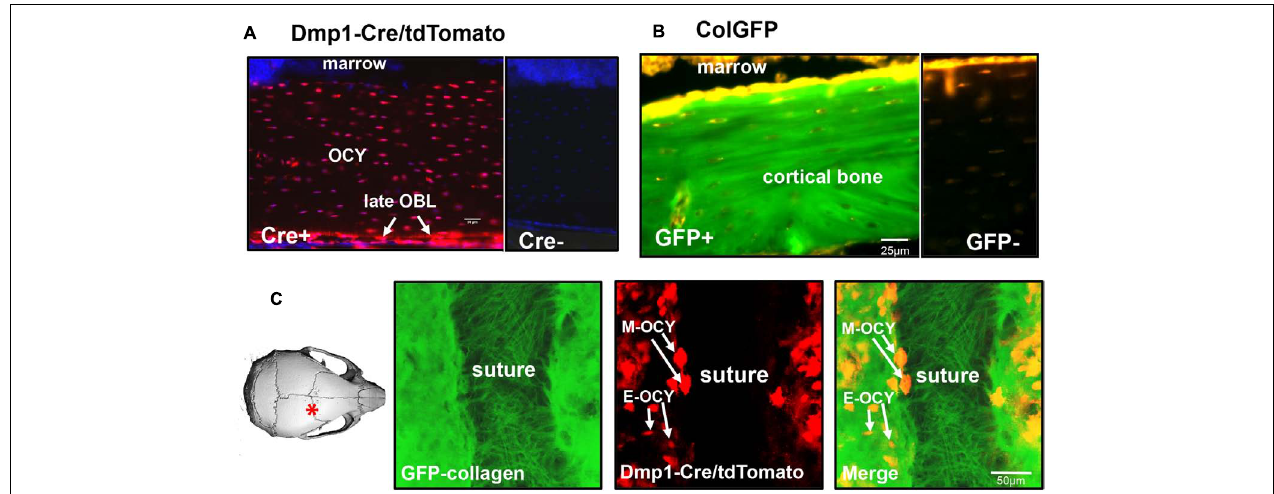
FIGURE 1 | Expression of fluorescent transgenes in GFP-collagen and Dmp1-Cre/tdTomato mice. (A) tdTomato expression in the femur (longitudinal section) of an 8 week old Dmp1Cre/tdTomato transgenic mouse (Cre+). A Cre negative littermate control is shown at right for comparison (Cre-). tdTomato expression is shown in red and DAPI nuclear stain is shown in blue. (OCY, osteocytes; late OBL, late osteoblasts), bar = 50 µ m. (B) GFP-collagen expression in the femur (longitudinal section) an 8 week old GFP-collagen transgenic mouse (GFP+). A GFP-negative littermate is shown at right for comparison (GFP-). GFP-collagen is shown in green and tissue autofluorescence appears yellow/orange, bar = 25 µ m. (C) Still frame from intravital imaging in a 15 day old GFP-collagen/Dmp1-Cre/tdTomato transgenic mouse. The image on the left illustrates the location of the imaging field. GFP collagen is shown in green and tdTomato is shown in red. (E-OCY, embedded osteocytes; M-OCY, larger tdTomato-positive cells that are motile, located at the edge of the suture), bar = 50 µ m. Panel (A) is modified from Dallas et al. (2018) with